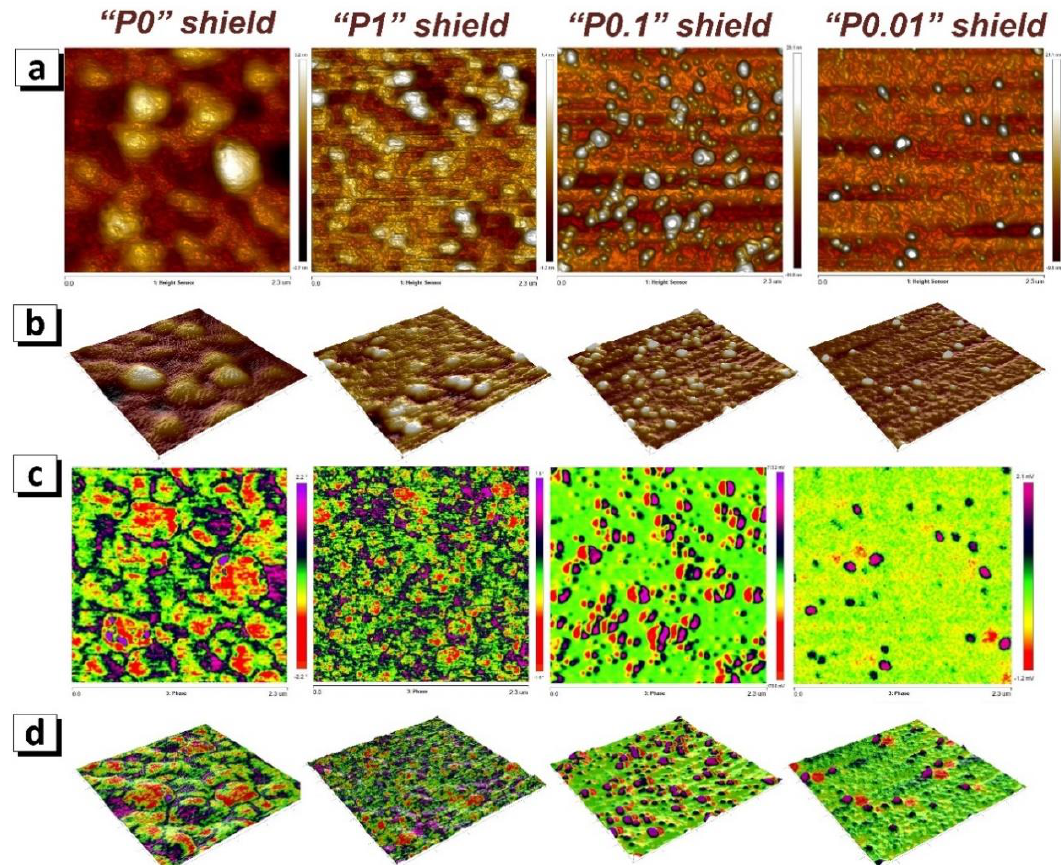
Figure 6. Surface microstructure of FeNi shielding coating investigated using atomic force microscope (AFM) and magnetic domain structure investigated using magnetic force microscopy (MFM, scan sizes are 2.3 μm × 2.3 μm): ( a ) 2D surface microstructure, ( b ) 3D surface microstructure, ( c ) 2D domain structure, ( d ) domain structure superimposed as a colored skin on the 3D image of the surface microstructure.